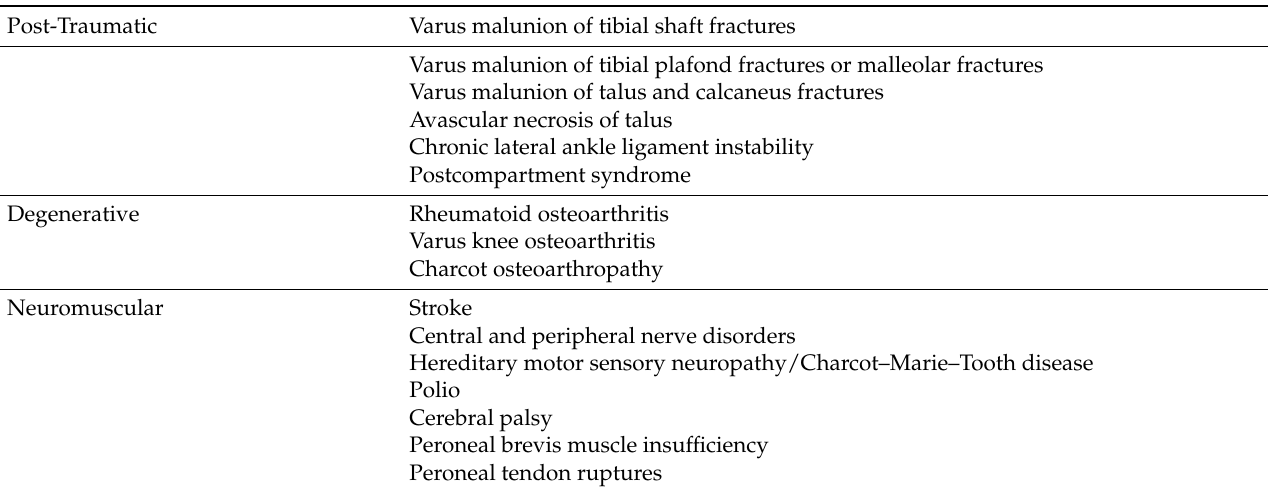
Table 1. Etiologies of the Varus Ankle Osteoarthritis (OA).